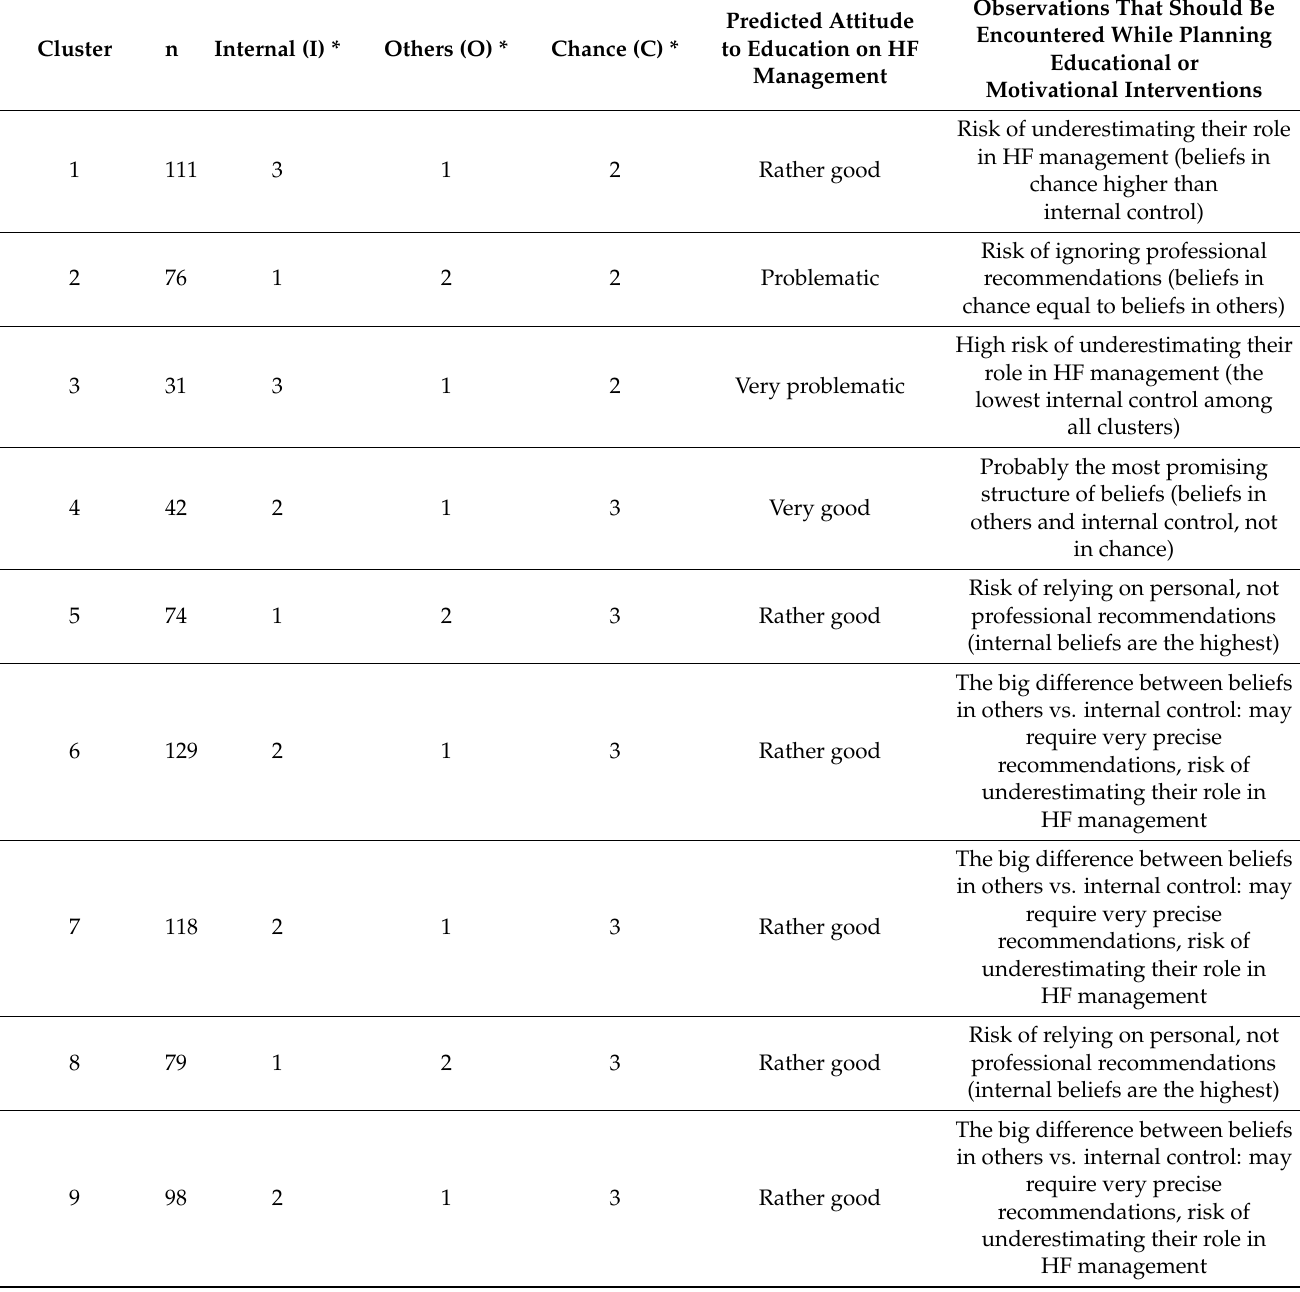
Table 1. Summary and comparison of 9